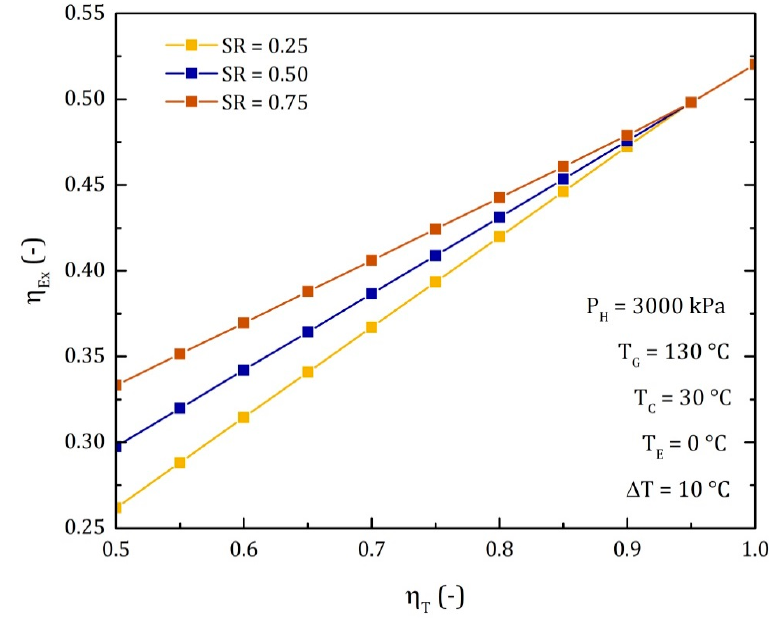
Figure 13. η EX as a function of η T for Model III at three di ff erent values of Figure 13. η (cid:2889)(cid:2908) as a function of η (cid:2904) for Model III at three different values of SR. Figure 13. η (cid:2889)(cid:2908) as a function of η (cid:2904) for Model III at three different values of SR.